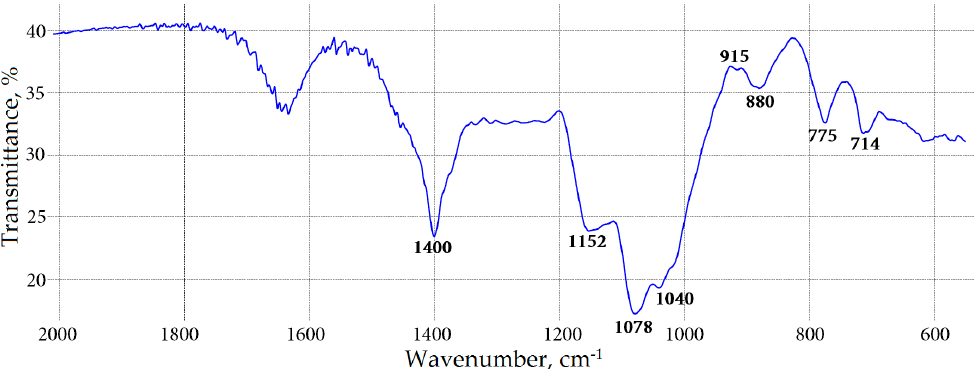
Figure 2. FT-IR spectra of water-soluble polysaccharide from F. denudata flowers.